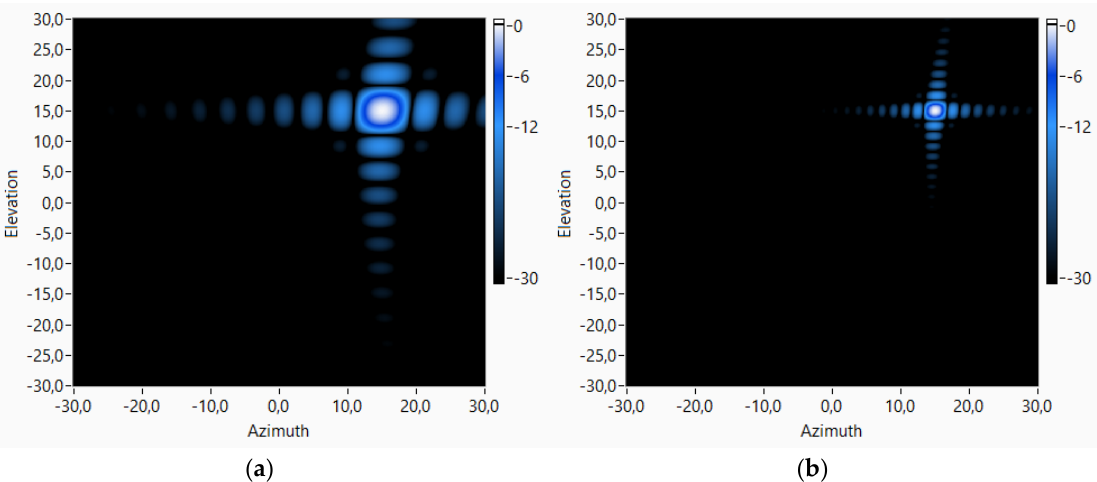
Figure 7. The 80 × 80 array theoretical beam pattern, pointing to (15°, 15°) direction, for working frequencies: ( a ) 4 kHz; and ( b ) 15 kHz.